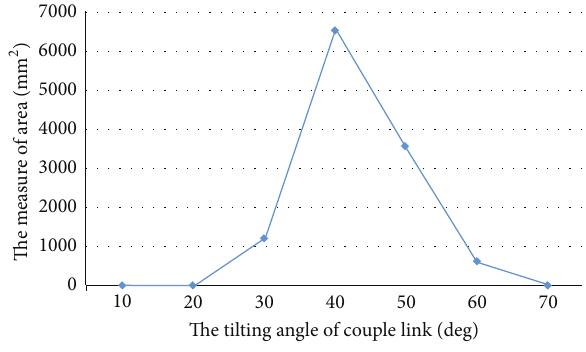
Figure 5: Double-crank four-bar mechanism.